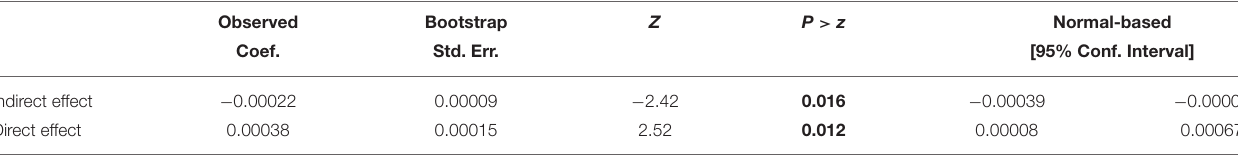
TABLE 14 | Bootstrap test of the mediating effect of body health in the impact of air pollution on anxiety. Observed Bootstrap Z P > z Normal-based Coef. Std.